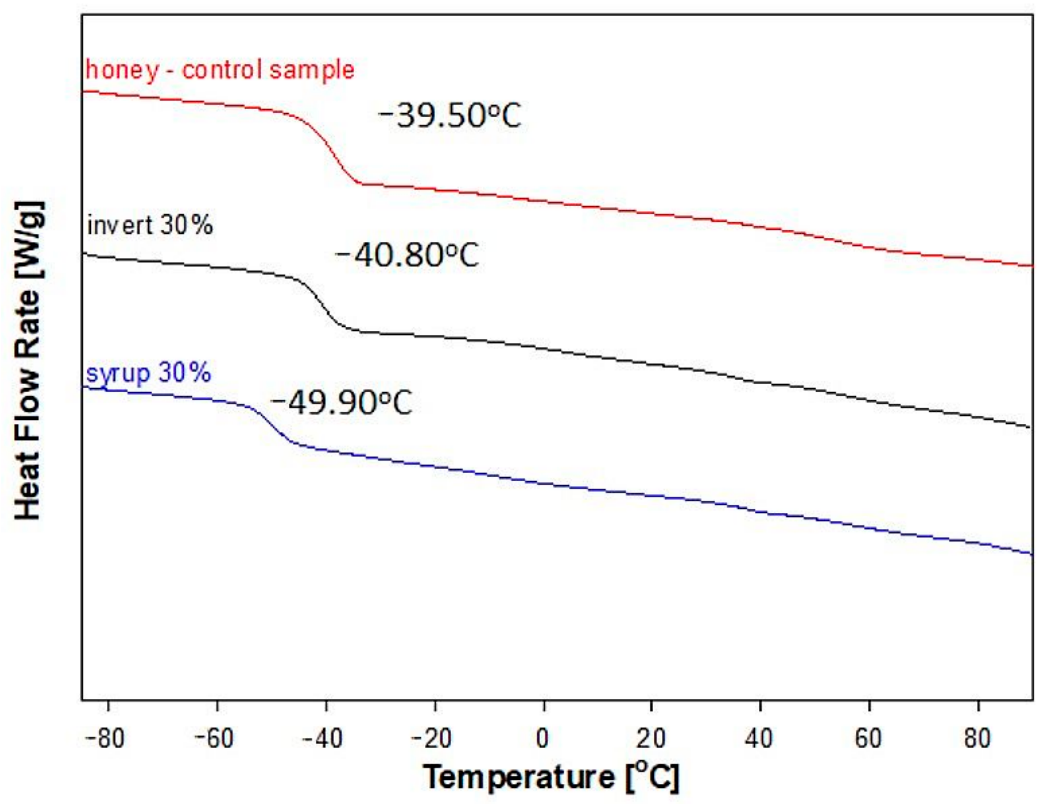
Figure 5. Comparison of heat flow rates of honey control sample and artificially adulterated honey by syrup 30% and invert 30% versus temperature.